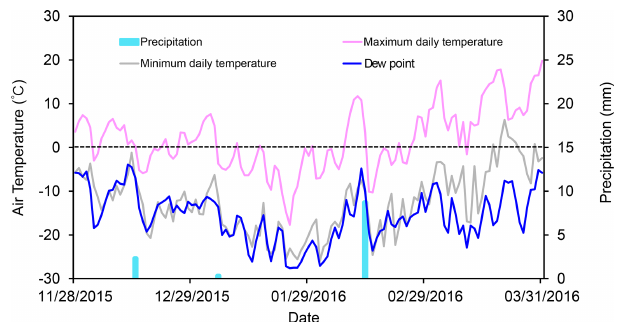
Figure 3. The maximum daily air temperature, the minimum daily air temperature, dew-point temperature, and precipitation during the freezing–thawing cycle from 28 November 2015 to 1 April